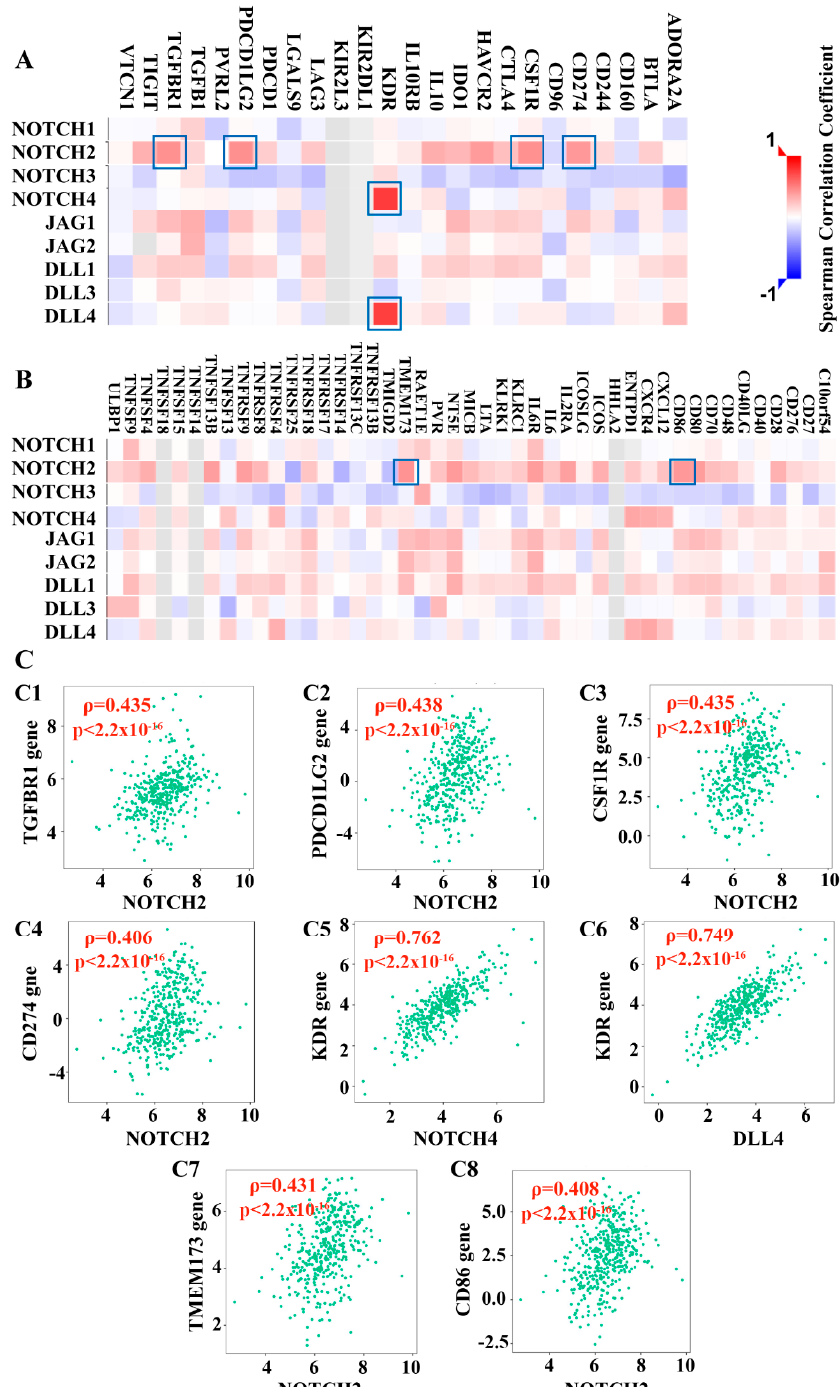
Figure 5. Relationship of the Notch pathway with the gene expression of immunomodulators in BCa. ( A ) The heatmap of the correlation with immunoinhibitors ( n = 408). ( B ) The heatmap of the correlation with immunostimulators ( n = 408). (i) The value of Spearman correlation coefficient is color-coded; high value is marked in red, low value is marked in blue. (ii) The most significant and representative results are marked with blue frames. ( C ) The representative positive correlations between Notch factors and various immunomodulators in BCa: NOTCH2 with TGFBR1 ( C1 ), NOTCH2 with PDCD1LG2 ( C2 ), NOTCH2 with CSF1R ( C3 ), NOTCH2 with CD274 ( C4 ), NOTCH4 with KDR ( C5 ), DLL4 with KDR (C6), NOTCH2 with TMEM173 ( C7 ), and NOTCH2 with CD86 ( C8 ). p -value. x -axis = expression level of target gene, y -axis = expression level of immunomodulator gene; scatter plots show curved patterns of the samples. TISIDB (http://cis.hku.hk/TISIDB/browse, accessed on 18 March 2021)